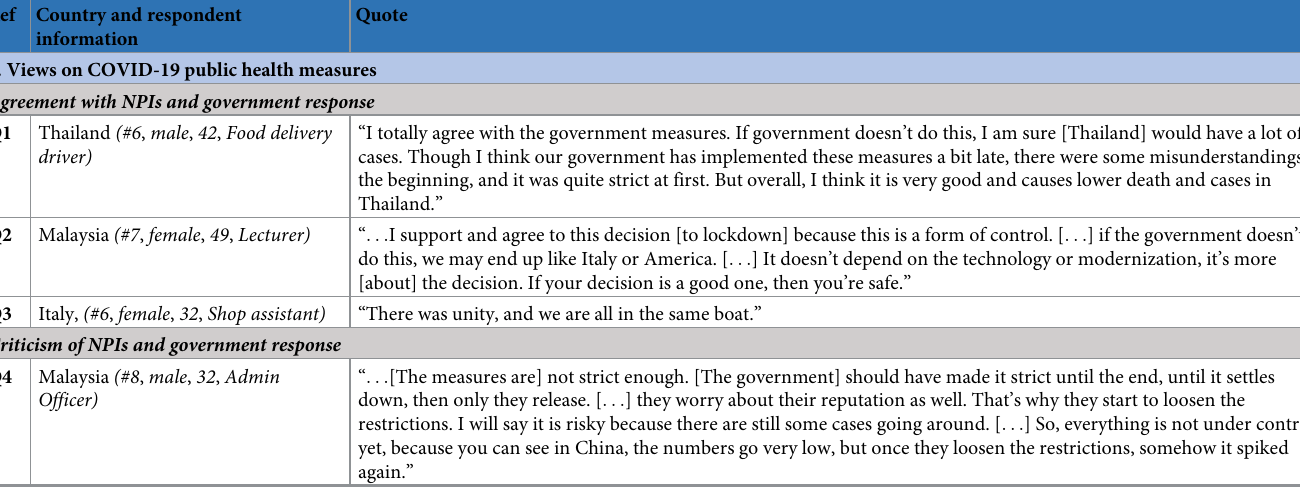
Table 2. Supporting quotes from in-depth interviews conducted across four